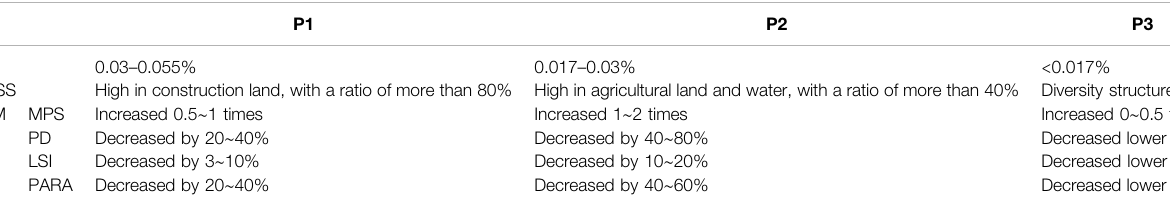
TABLE 5 | The indicator intervals of three type areas.